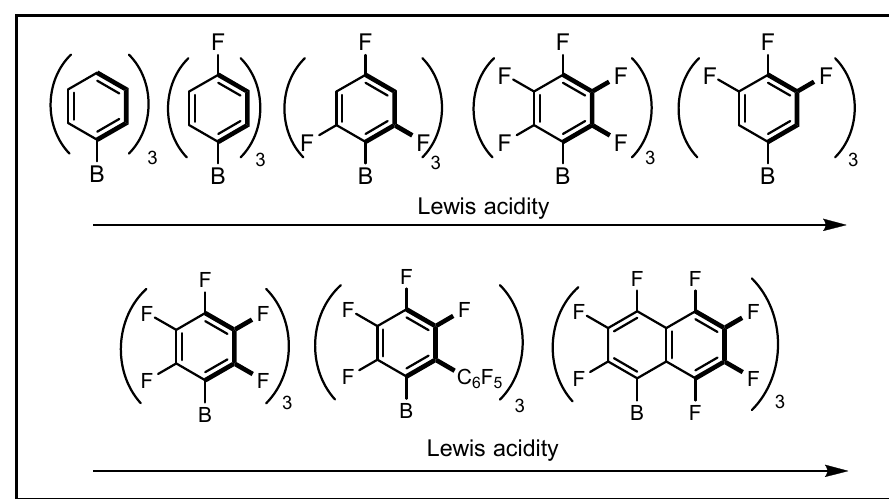
Figure 1. The Lewis acidity of fluoroaryl boranes with different substitutions.